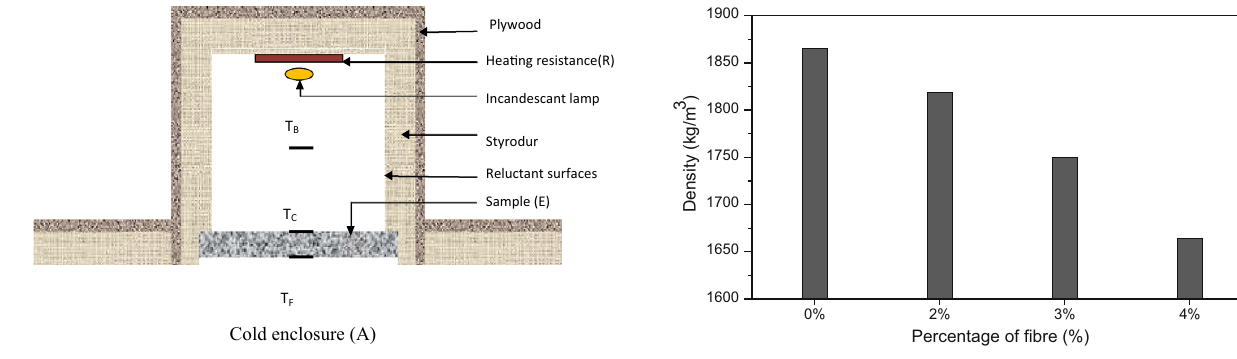
Fig. 2 Thermal conductivity and diffusivity measuring box and tube positions